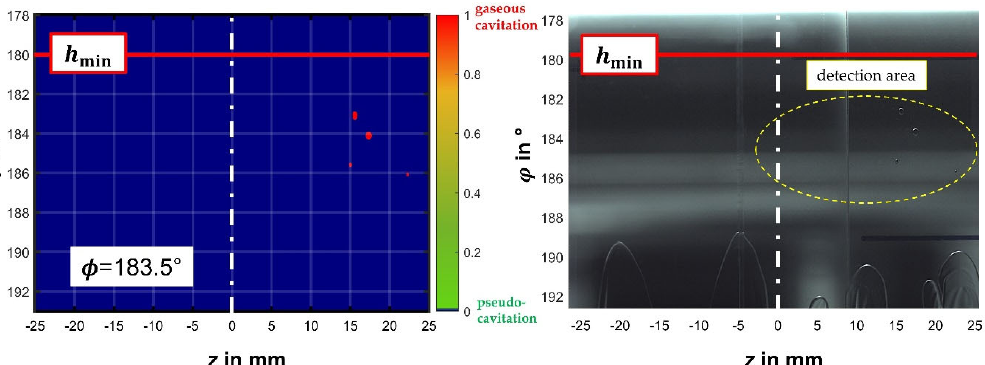
Figure 12. Phase 1: inception of bubbles by solely gas cavitation, rotational angle φ = 183.5 ◦ after initiation of transient radial displacement, fluid: paraffin containing 100% dissolved air.